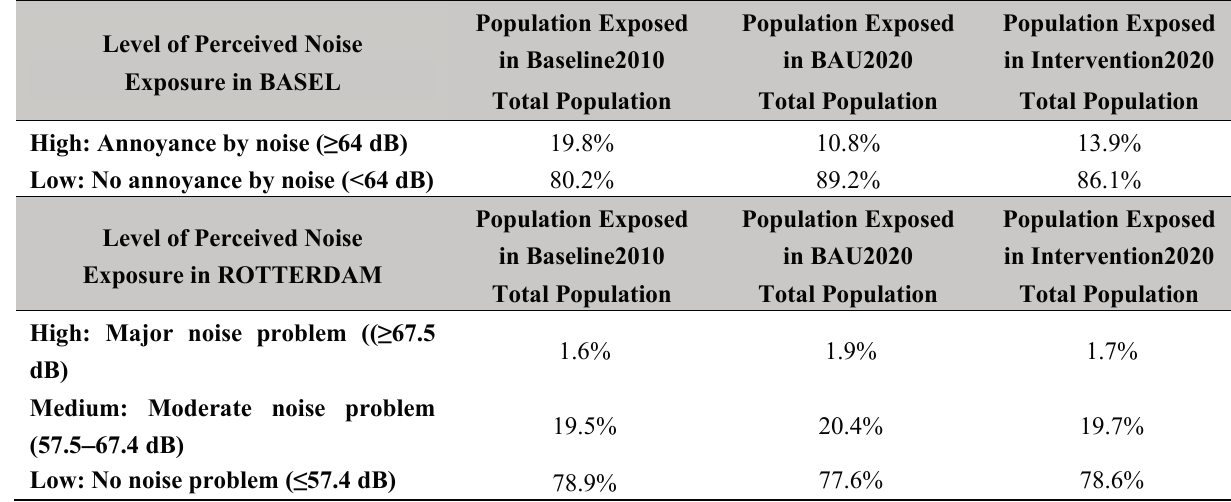
Table 5. Changes of perceived noise exposure in the case study